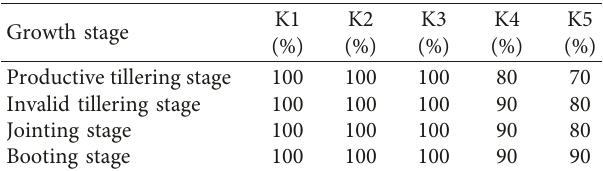
Table 6: Identification accuracy of different K levels at different growth stages.